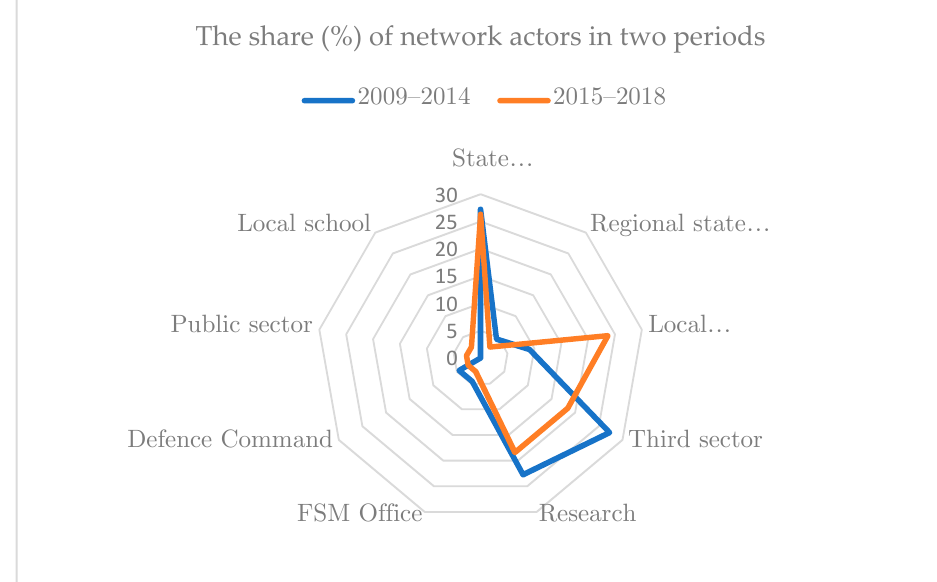
Figure 2. The share (%) of network actors in the two periods.